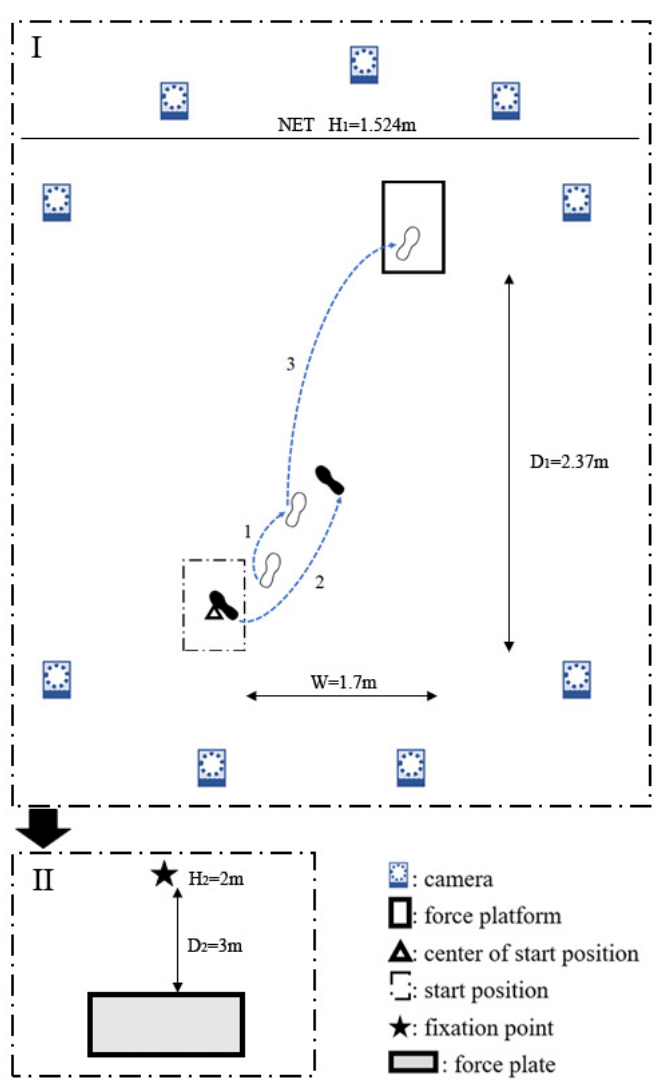
Figure 1. Illustration of footwork and testing process. The badminton athletes lunged and followed the footwork shown in I, and repeated until exhausted. Then, they took II, the poster sway test, standing on a plantar pressure plate using their dominant leg. In the illustration of lunge footwork, the right leg is dominant. The open foot marks represent the foot placements of the right foot, whereas the solid foot marks represent the foot placements of the left foot. The numbers represent the step sequences.